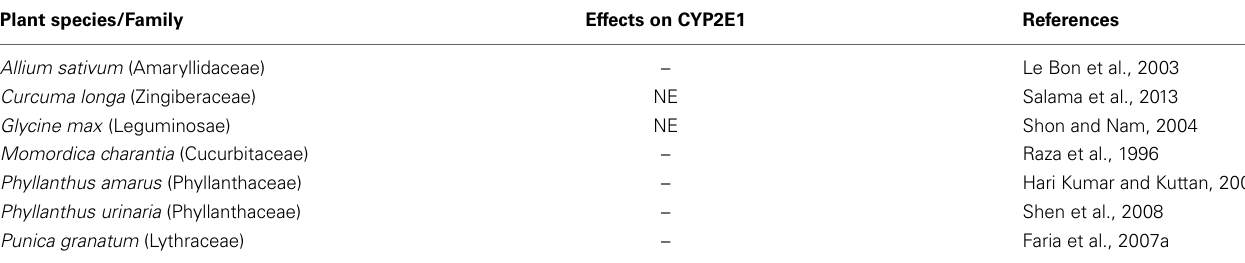
Table 5 | Medicinal plant species listed in RENISUS with reported effects of on CYP2E1. Plant species/Family